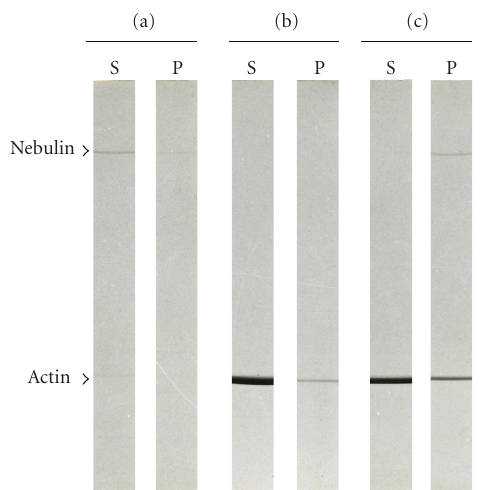
Figure 5: Binding of purified nebulin and F-actin examined by cosedimentation. (a) nebulin only, (b) actin only, (c) nebulin + actin. (S) supernatant after centrifugation, (P) pellet after centrifu- gation. Nebulin and actin were mixed in 0.11M KPO 4 , 0.31 M urea, 0.27mM ATP, and 0.1 mM MgCl 2 , pH 7.0. Electrophoresis was performed on a 2–15% polyacrylamide